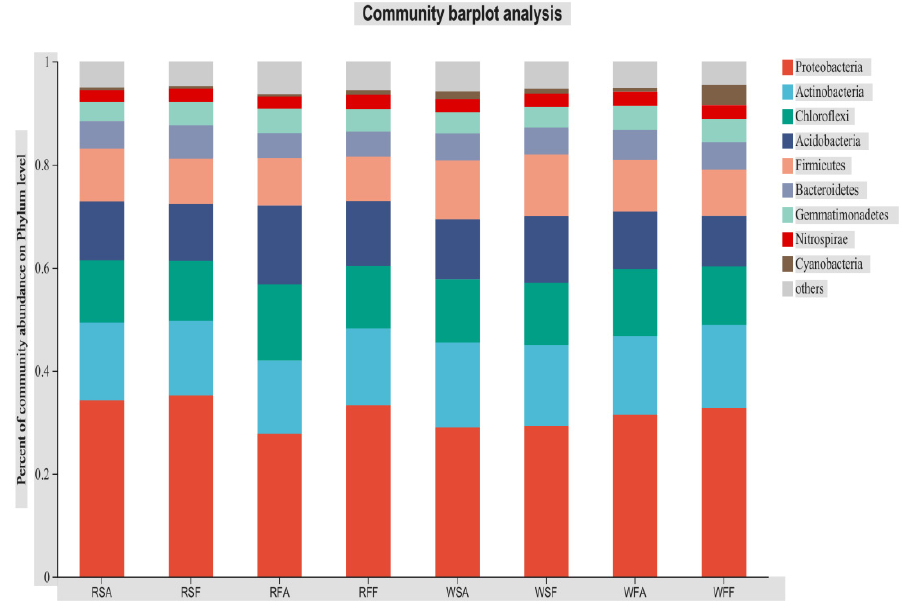
Figure 1. The effect of APRI with reclaimed water on soil microbial community at phylum level.